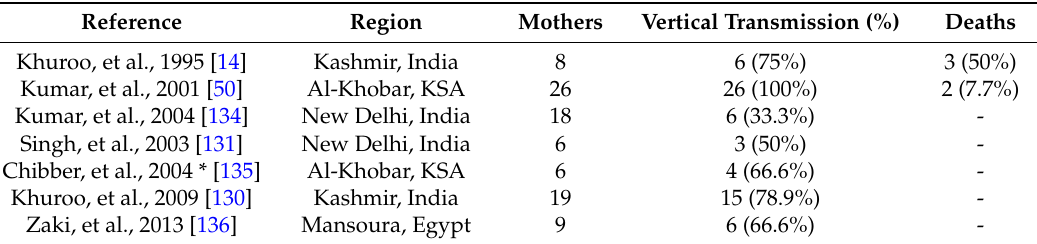
Table 3. Vertical transmission of hepatitis E from mother to